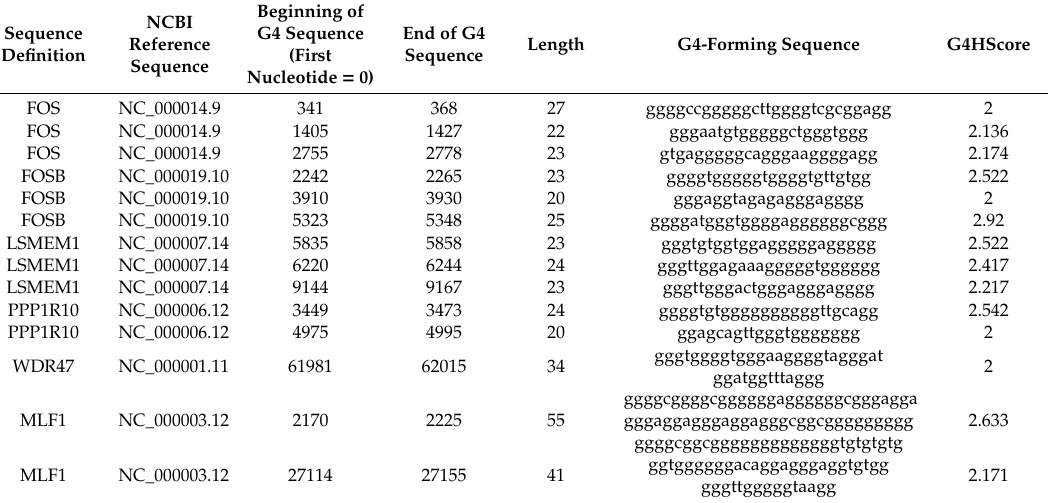
Table 4. Prediction of G-quadruplexes within early response genes’